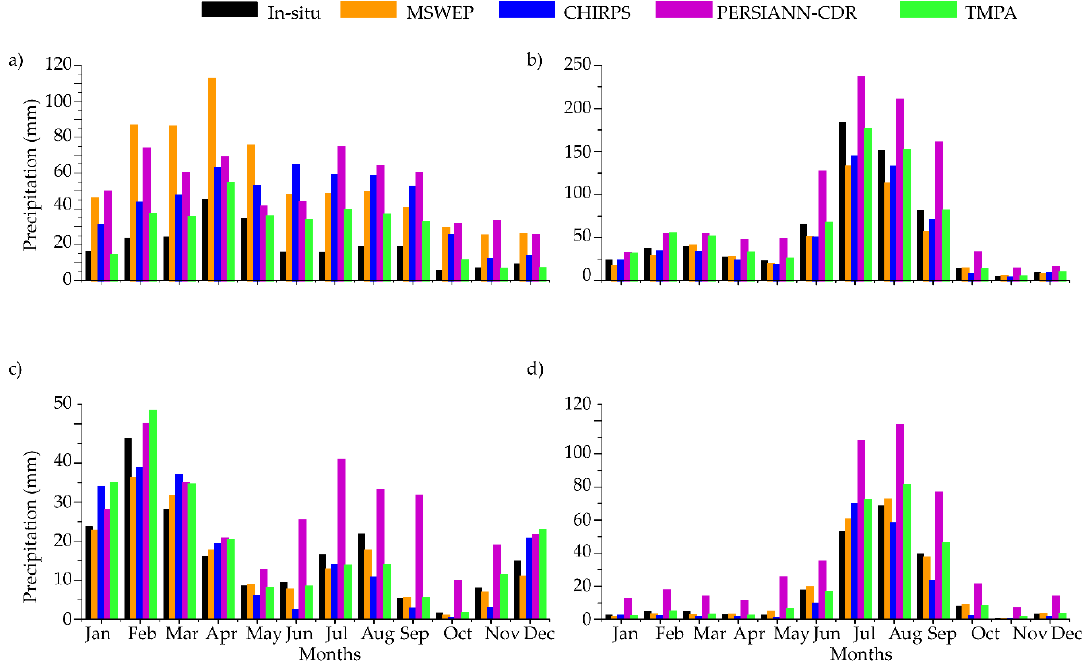
Figure 3. Climatological mean annual precipitation cycle at four selected locations. ( a ), ( b ), ( c ) and ( d ) are equivalent to regions 1, 2, 3 and 4 in Table 1.